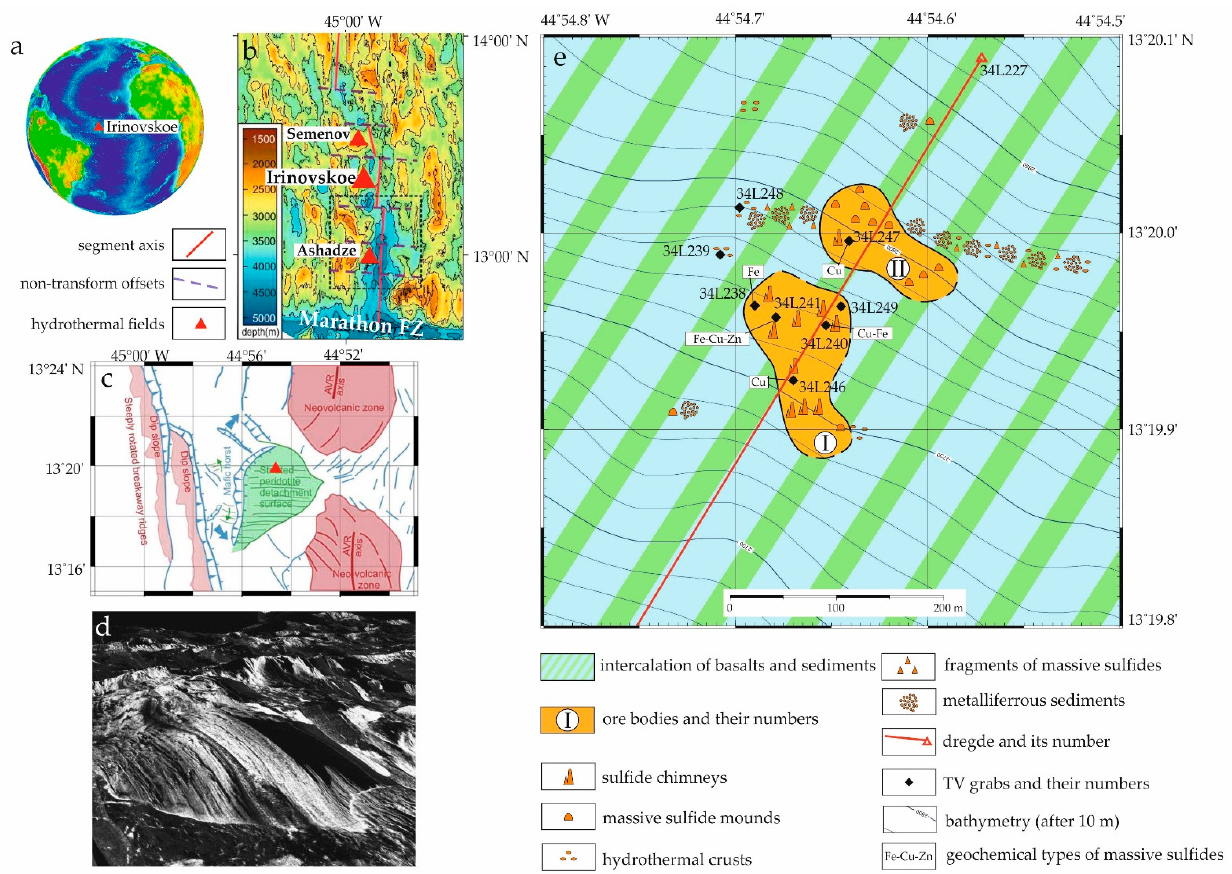
Figure 1. ( a , b ) Location of the Irinovskoe HSF within the Mid-Atlantic Ridge; ( c ), interpretation of structure and geological relationships in the HSF area after [22] (an approximate position of the hydrothermal field is marked by a red triangle); ( d ) three-dimentional perspective view looking NW of active striated detachment surface emerging from axial valley floor after [22]; ( e ) schematic map of the HSF, simplified after an unpublished in-house PMGE report, 2011.